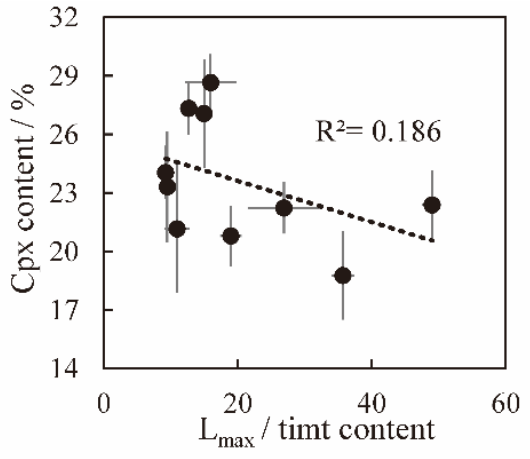
Figure 12. Relationship between volume content of Cpx (clinopyroxene) in Hannuoba samples and L max /timt content. Some error bars smaller than the symbols are not shown.